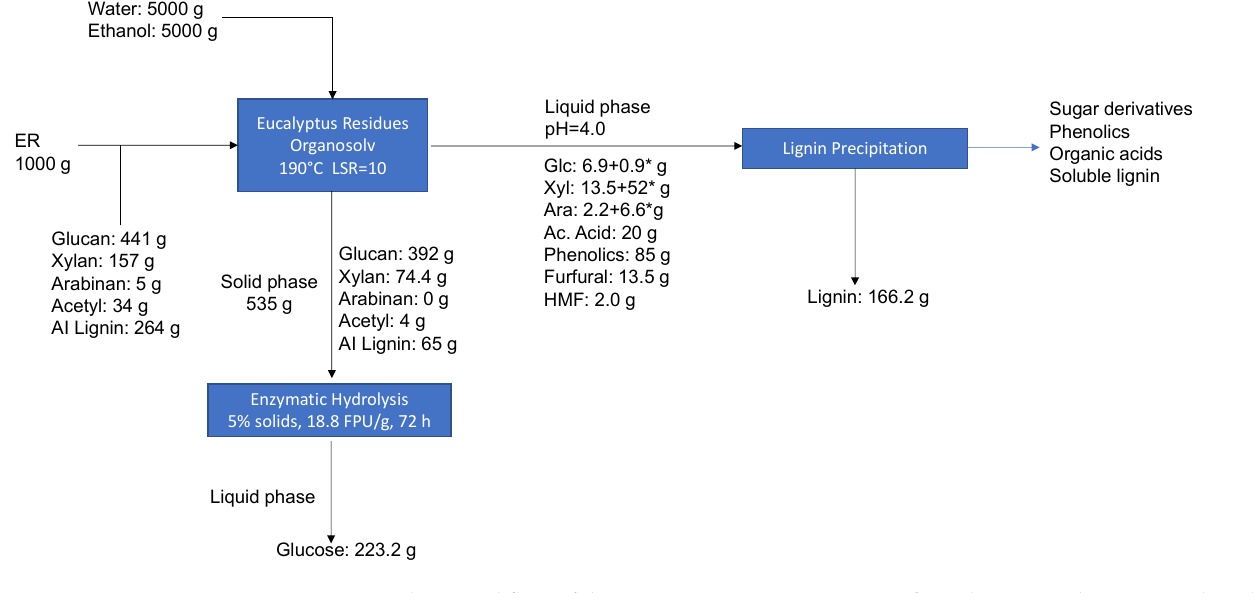
Figure 13. Balance and flow of the main constituent processing of eucalyptus residues using ethanol- organosolv at 190 °C (120 min) without catalyst and enzymatic hydrolysis. * Denotes sugars in oligomeric form.